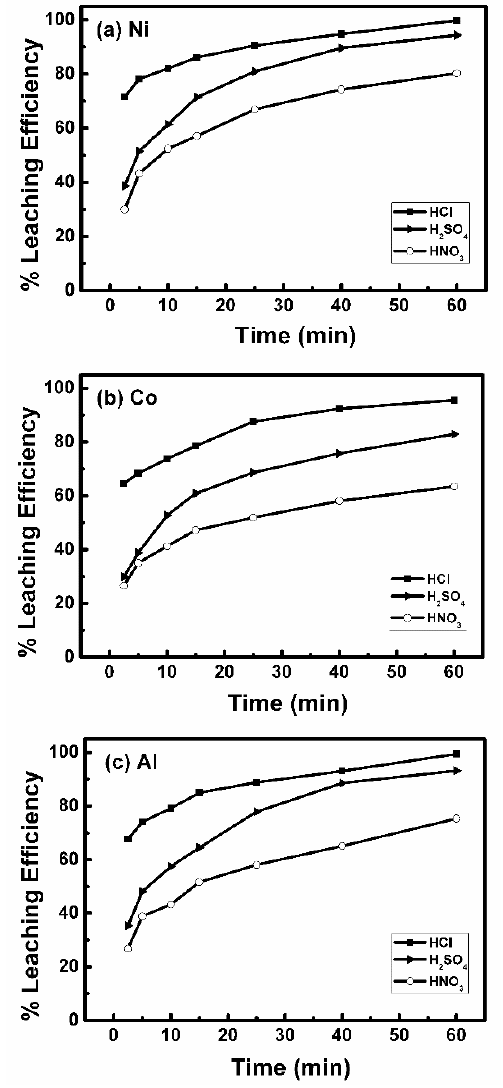
Figure 6. Leaching behavior using various acids during 60 min of processing (4M, 80 °C): ( a ) Nickel; ( b ) Cobalt; ( c ) Aluminum.